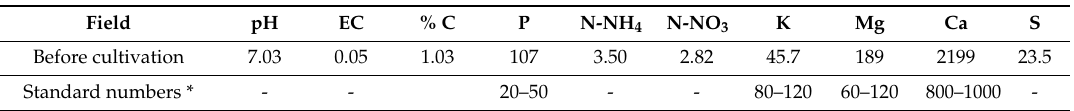
Table 1. Soil reaction (pH in H 2 O), salinity ((EC) electrical conductivity, mS cm − 1 ), and macronutrient content (mg dm − 3 ) in the soil before the start of the experiment in April